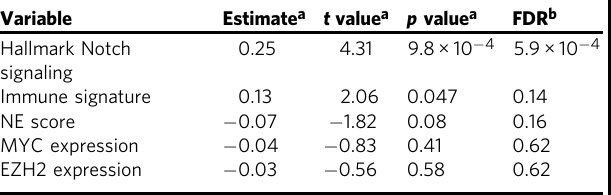
Table 2 Notch signaling gene set is the most signi fi cant predictor of clinical bene fi t to immune checkpoint blockade across relapsed SCLC